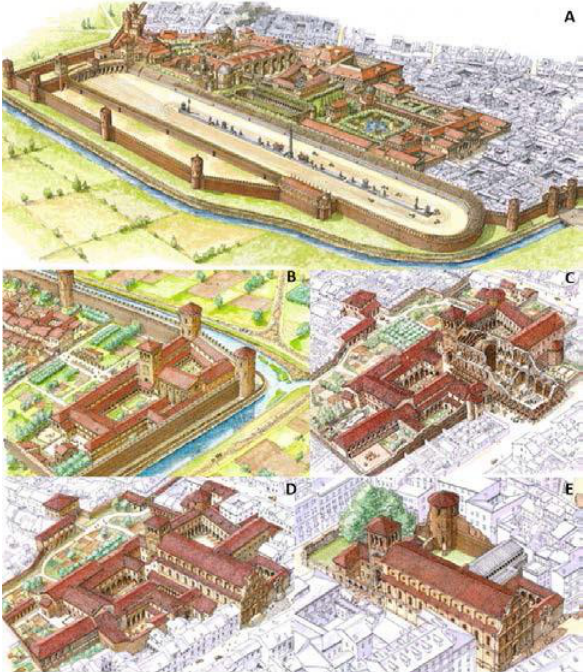
Figure 2. The Area of the Circusr (by F.Corni): A- Roman 3 rd - 4 th century; B- Monastery 8 th -9 th ; C- 16 th the Church; D- 17 th - 18 th Transformation; E 20th century Museum’s Area.